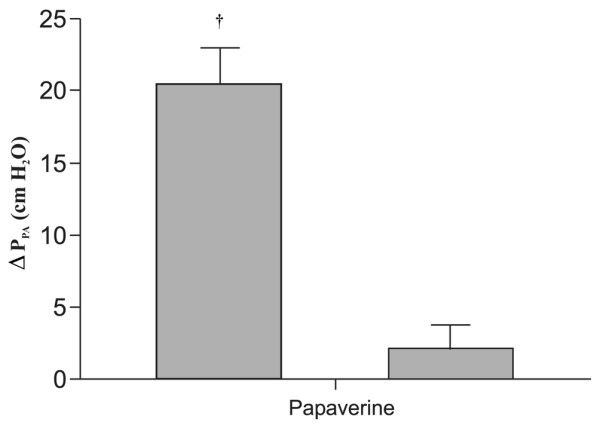
Pulmonary arterial pressure responses (ΔPPA) to endothelin-1 (ET-1) before and after papaverine administration in isolated lungs. Data are presented as mean ± SEM. †p < 0.05 from baseline.